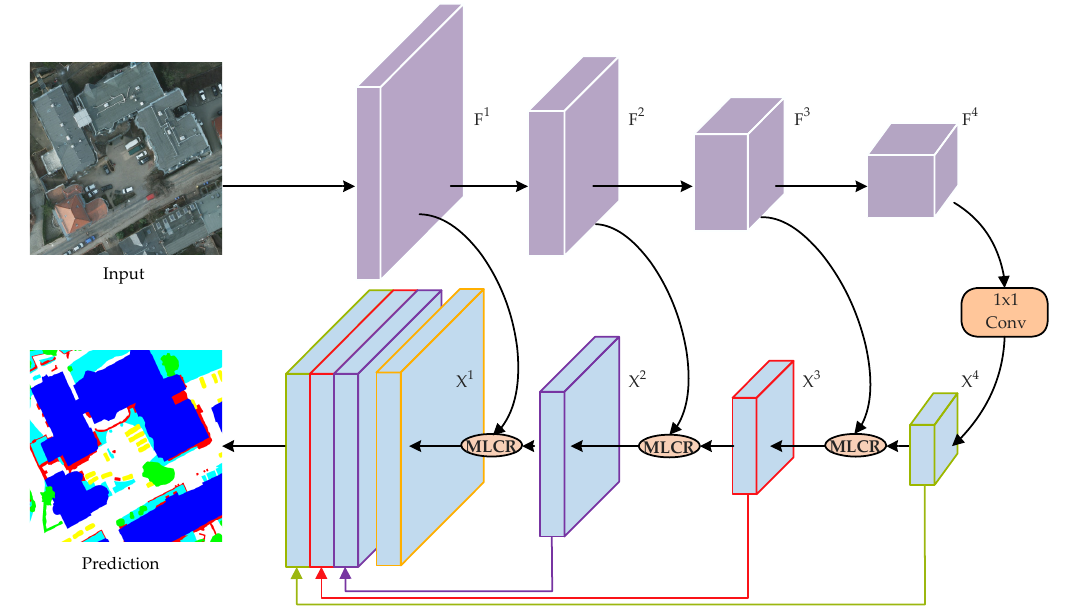
Figure 6. Overview of the proposed MLCRNet.